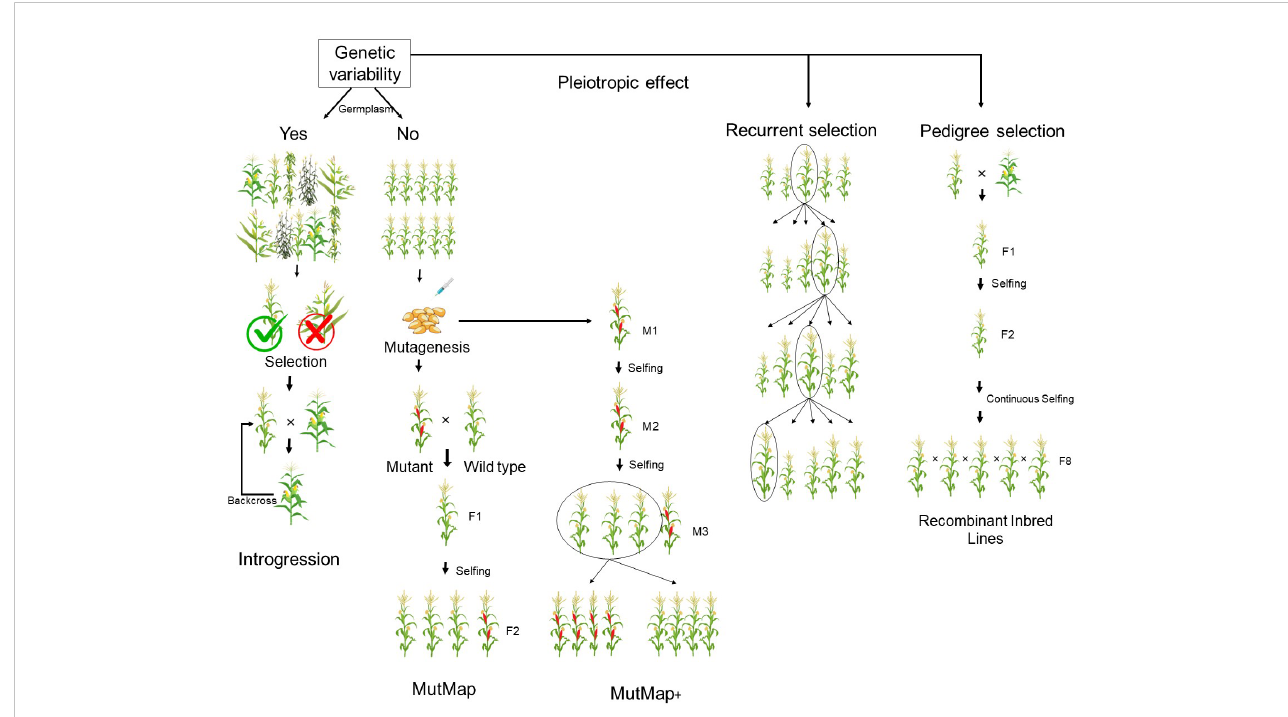
FIGURE 2 Breeding methods focused for reducing anti-nutritional